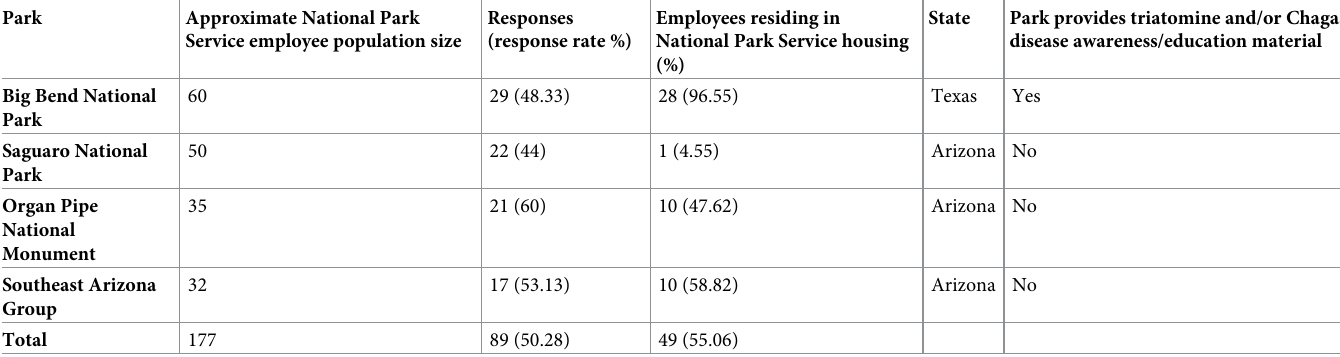
Table 1. Survey response rates by national park and park-related information.